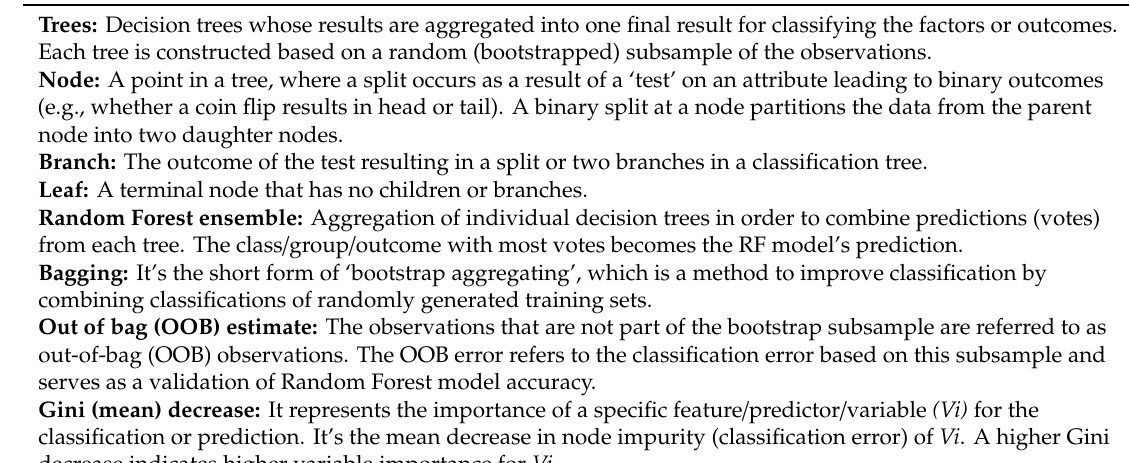
Table A1. Concepts and parameters used in Random Forest classification